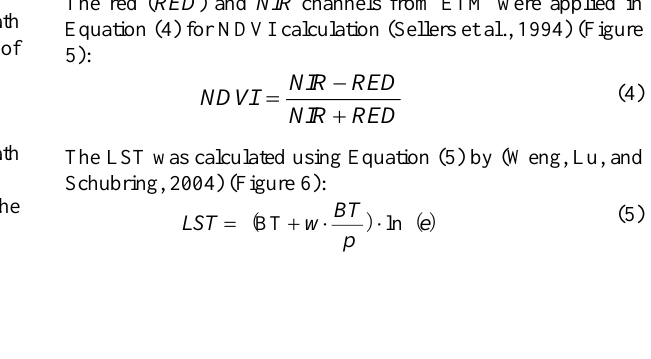
Figure 4. SMI map from Landsat +ETM7 The red ( RED ) and NIR channels from ETM were applied